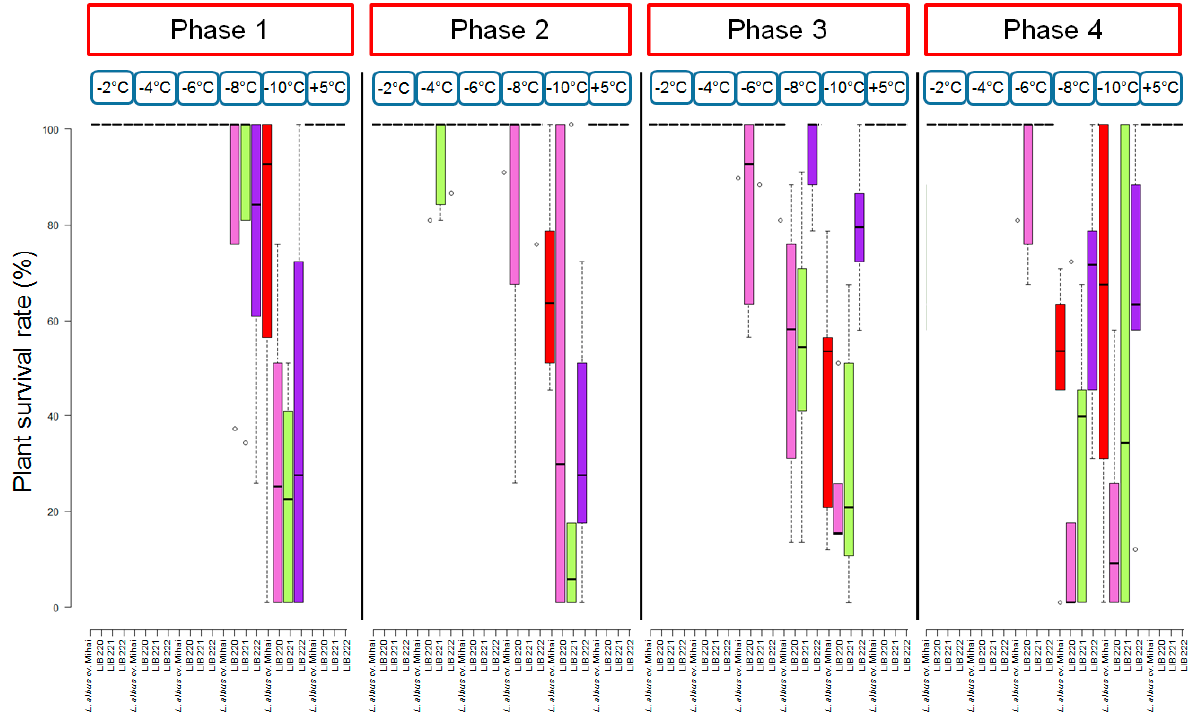
Figure 5. Assessment of Andean lupin accessions under the influence of artificial ‐ frost test temperatures ranging from low ( − 2 ◦ C) to high ( − 10 ◦ C) frost stress and with control samples at (+5 ◦ C) and plant developmental phases, from Phase 1 to Phase 4. Each genotype is color coded: L. albus cv. Mihai (red), LIB 220 (orchid), LIB 221 (olive ‐ green), and LIB 222 (purple) .